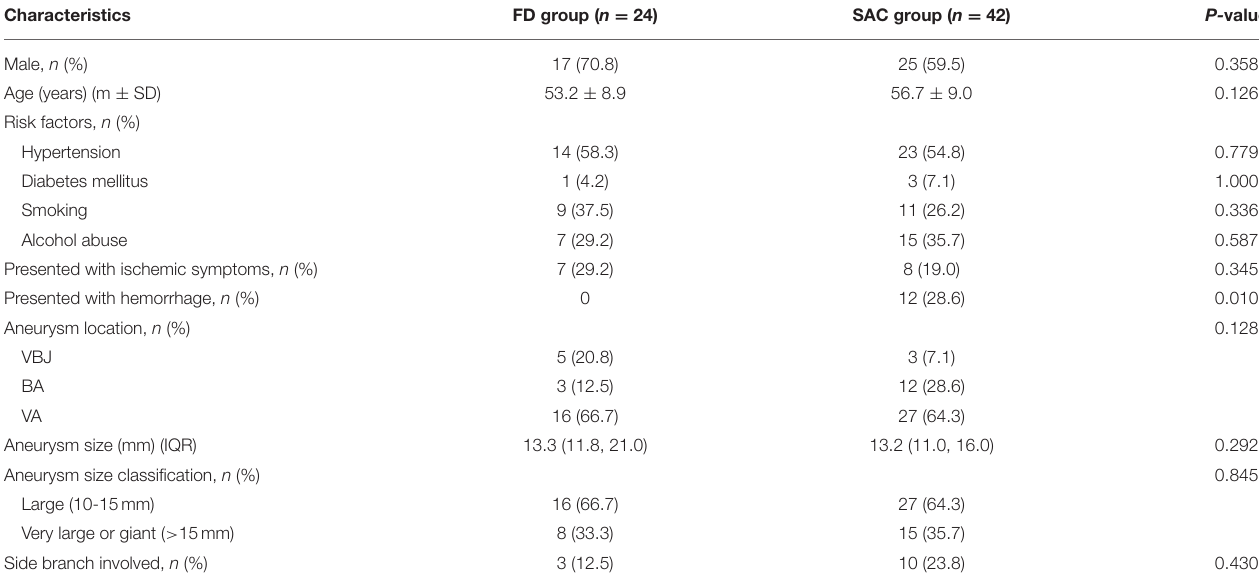
TABLE 1 | Baseline characteristics of patients and aneurysms. Characteristics